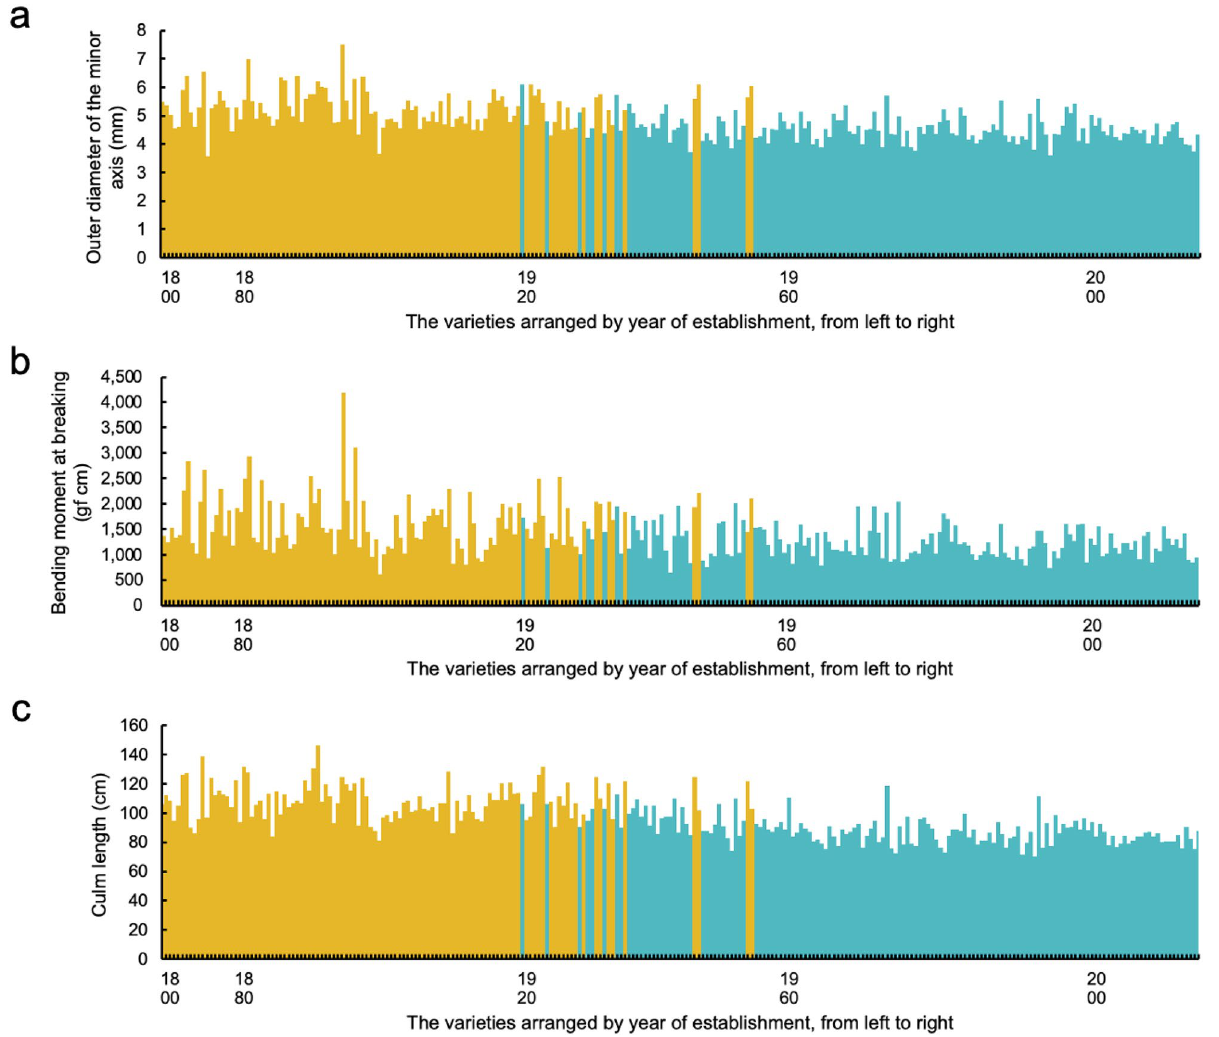
Figure 3. Phenotypic values of the studied varieties arranged in chronological order. Bar graphs of trait values of the varieties arranged by year of establishment, from left to right: ( a ) ODMI; ( b ) BM; ( c ) culm length. The 2019 data of phenotypic values were used, those whose year of establishment was unclear were removed. The yellow and blue bars indicate landraces and breeding varieties,